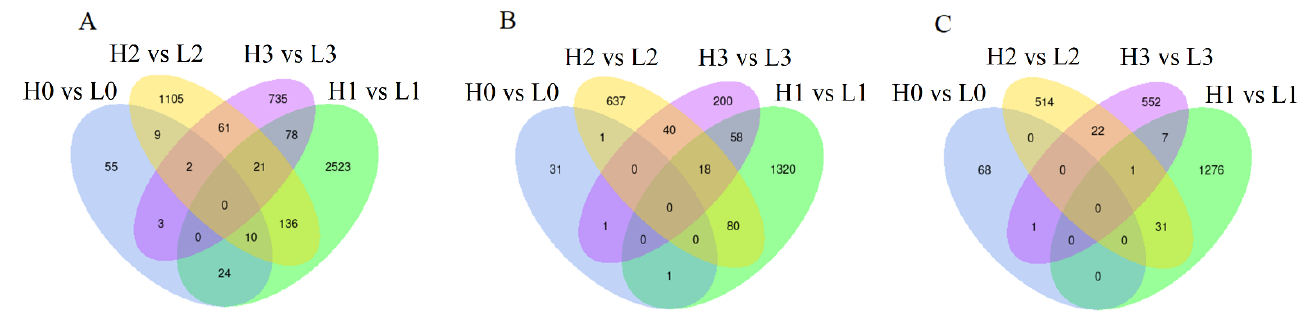
Figure 4. Venn diagram showing the differentially expressed genes (DEGs) in the 4 stages. ( A ) Total DEGs; ( B ) up-regulated DEGs; ( C ) down-regulated DEGs. L0, L1, L2, and L3 indicate the transcriptomic data at stage 0, stage 1, stage 2, and stage 3 under low R/FR ratio (0.1), while H0, H1, H2, and H3 indicate the transcriptomic data at stage 0, stage 1, stage 2, and stage 3 under high R/FR ratio (0.2).